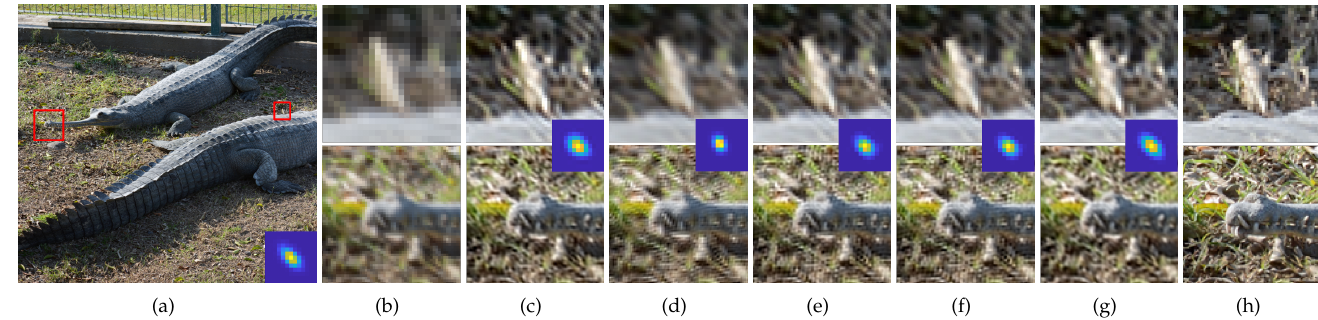
Figure 9. SR results of the 95th image of DIV2KRK dataset using the estimated kernels for scale factor of × 2. The first row is the ZSSR results and the second row is the results of solving Equation (2). From ( c ) to ( g ), the estimated kernels are shown in the middle of each column. ( a ) GT image and kernel, ( b ) LR, ( c ) KernelGAN [20], ( d ) FKP [21], ( e ) E-KernelGAN [22], ( f ) E-KernelGAN-DIP [22], ( g ) TVG-KernelGAN, ( h ) GT.